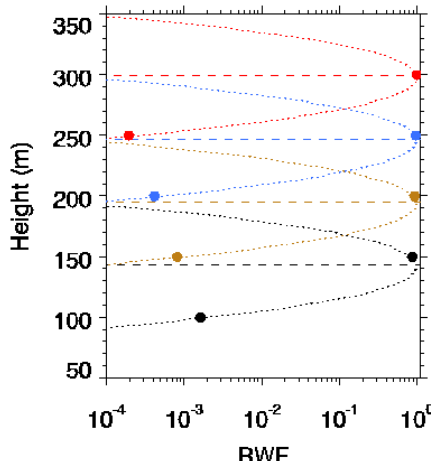
Figure 5. Range weighting functions (RWFs) used to interpolate the sonic measurements to the heights of the lidar range gates. The dashed horizontal lines show the heights of the lidar range gates, and the solid filled circles show the heights of the sonic anemome- ters and the range-weighting values that were used in Eq. (14). Dif- ferent colors are used to distinguish the lidar range gates and corre- sponding RWFs.